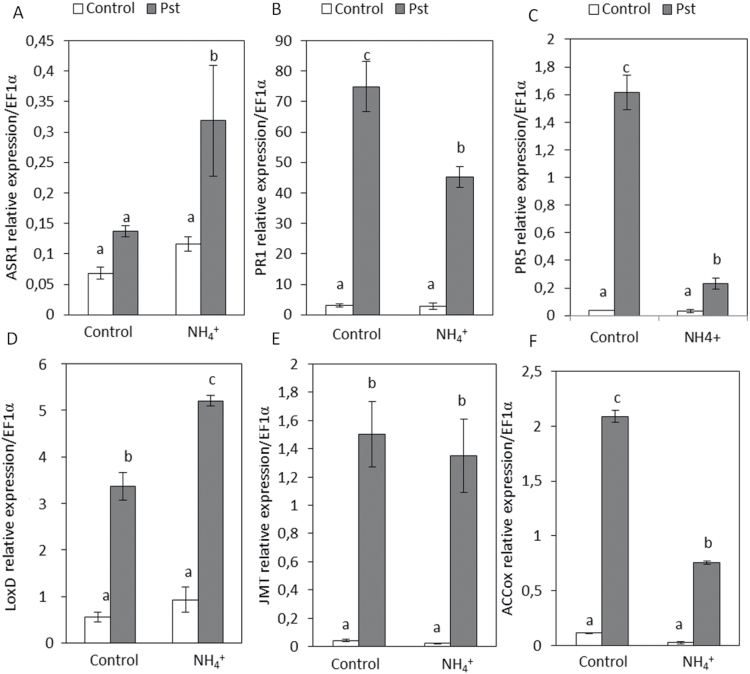
Gene expression profile of plant defence pathways in control and N-NH4
+ tomato plants upon Pst infection. Plants were grown and inoculated as described in Fig. 2. The expression of genes representing key components of ABA (Asr1) (A), SA (PR1 and PR5) (B and C), JA (LoxD and JMT) (D and E), and ethylene (ACCOx) (F) signalling pathways were analysed in cDNA from leaves of control and N-NH4
+ plants at 48 hpi. The results were normalized to the EF1α gene expression measured in the same samples. Data show the average of three independent experiments of a pool of 10 plants per experiment ±SE. Letters indicate statistically significant differences (P<0.05; least-significant difference test).